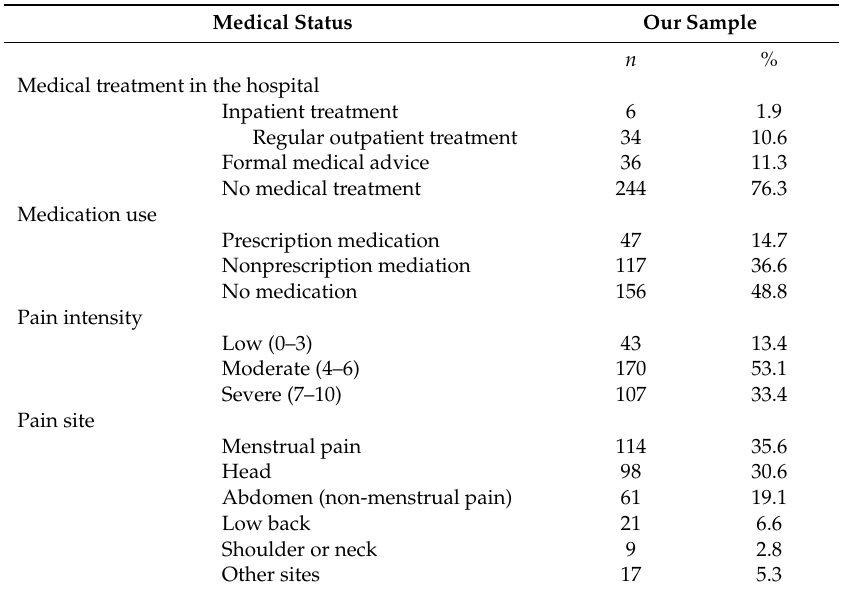
Table 1. Medical treatment in the hospital, medication use, pain intensity, and site of pain in a sample of women with chronic pain ( n =